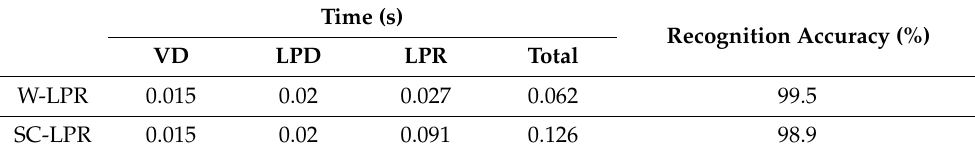
Table 4. The processing time and the recognition accuracy of the two approaches.